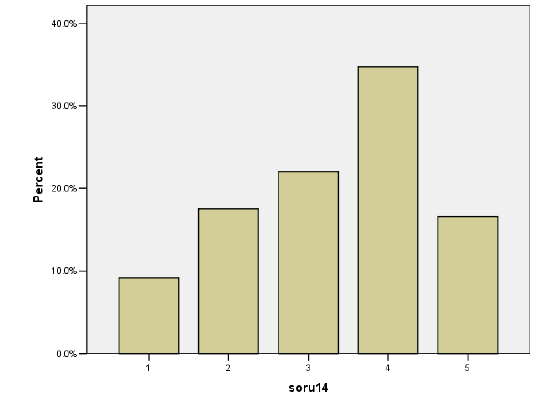
Figure 10. Do Financial (General) Accounting courses in Turkey include some topics and elements of international